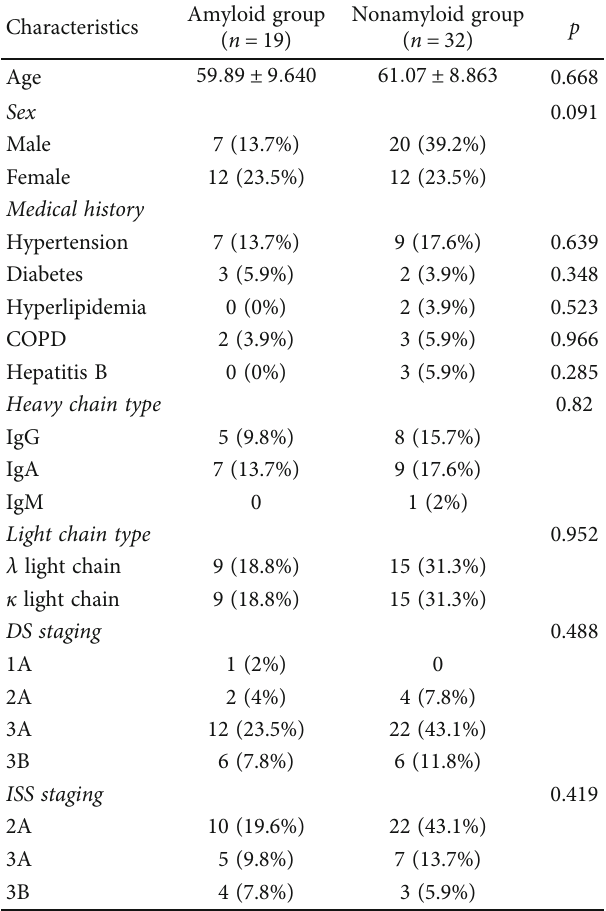
Table 1: Clinical and laboratory characteristics of participants.